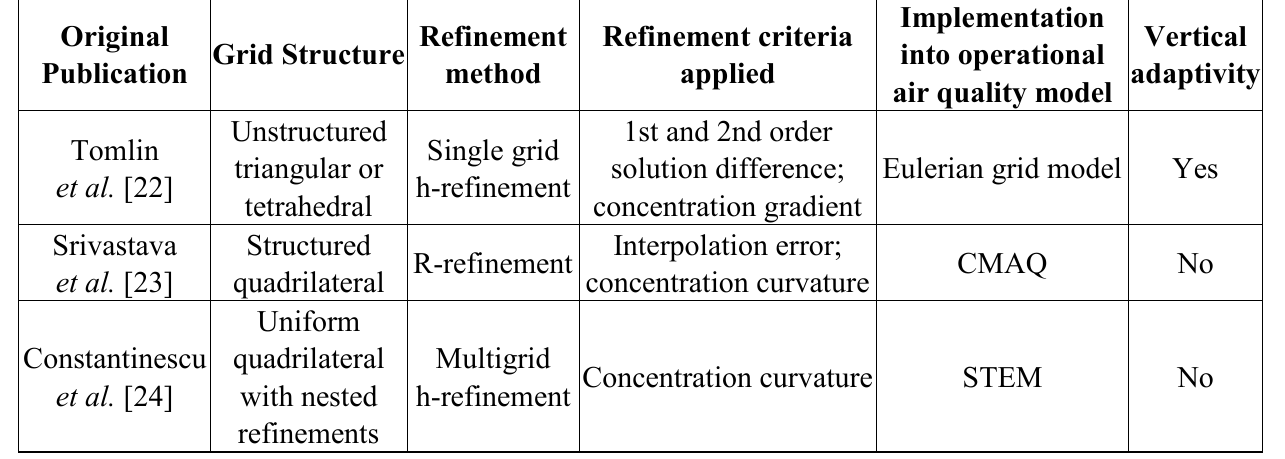
Table 1. Adaptive Grid Methods in Air Quality